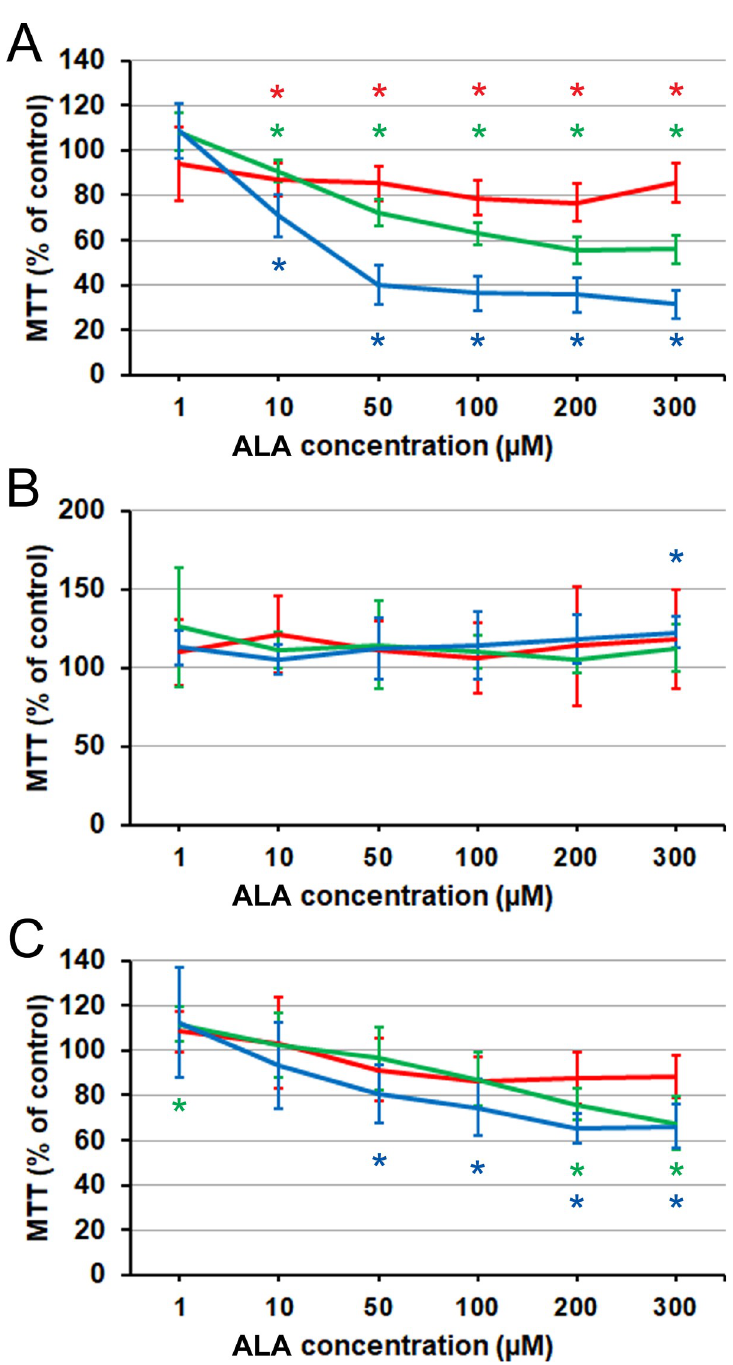
Fig 6. Effect of ALA on prostate cancer cells proliferation and viability as measured by MTT assay. (A) PC3 cells. (B) LNCaP cells. (C) C4-2 cells. Red line: 24 h. Green line: 48 h. Blue line: 72 h. Error bars: standard deviation. Asterisk: difference from the control is significant on the significance level 0.05, corrected for multiple comparisons. Each data point is the average of n = 9 cell cultures.